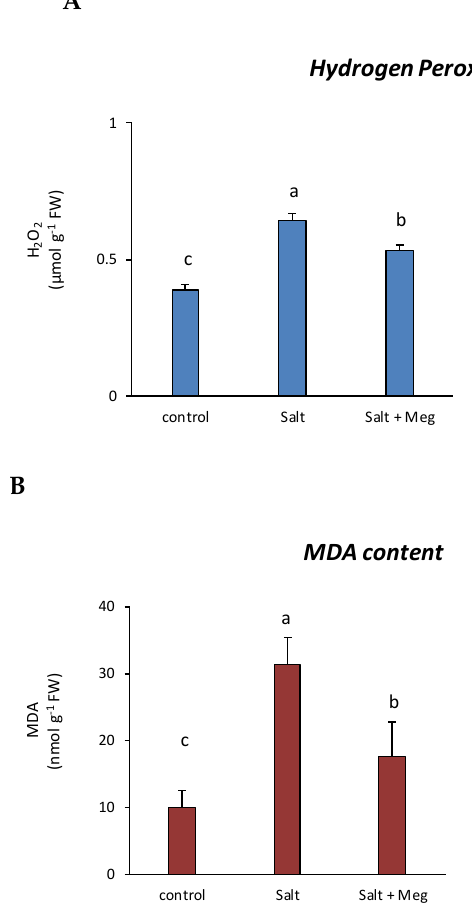
Figure 2. Contents of hydrogen peroxide (H 2 O 2 ) ( A ) and malondialdehyde (MDA) ( B ) determined in maize seedling controls, grown with NaCl alone and NaCl with the biostimulant (i.e., Control, Salt, Salt + Meg, respectively). Different letters within each column indicate statistically significant differences at p ≤ 0.05.